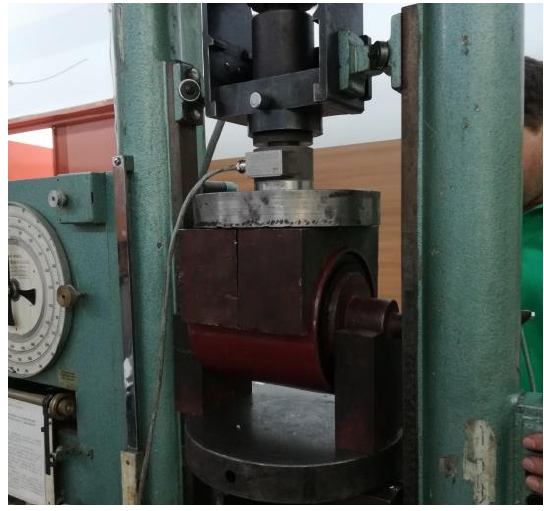
Figure 5. Experimental testing of radial deflection for a central bolt spring manufactured from A–615 compound.